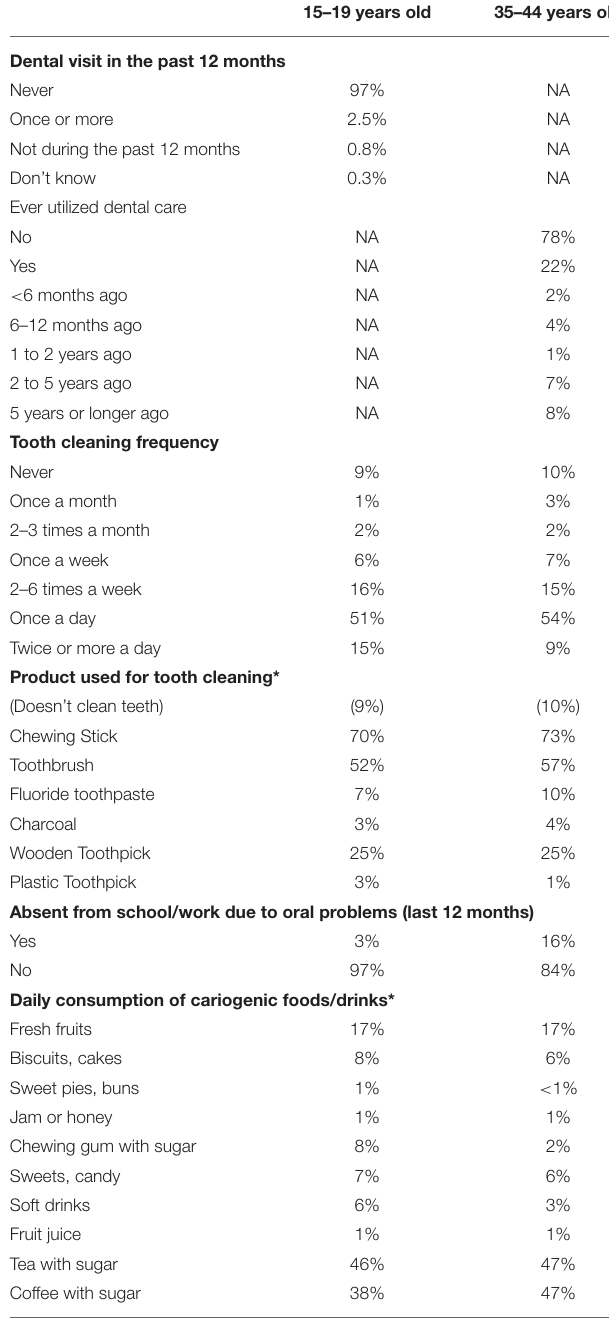
TABLE 2 | Number (%) of individuals by number of teeth and periodontal health status.